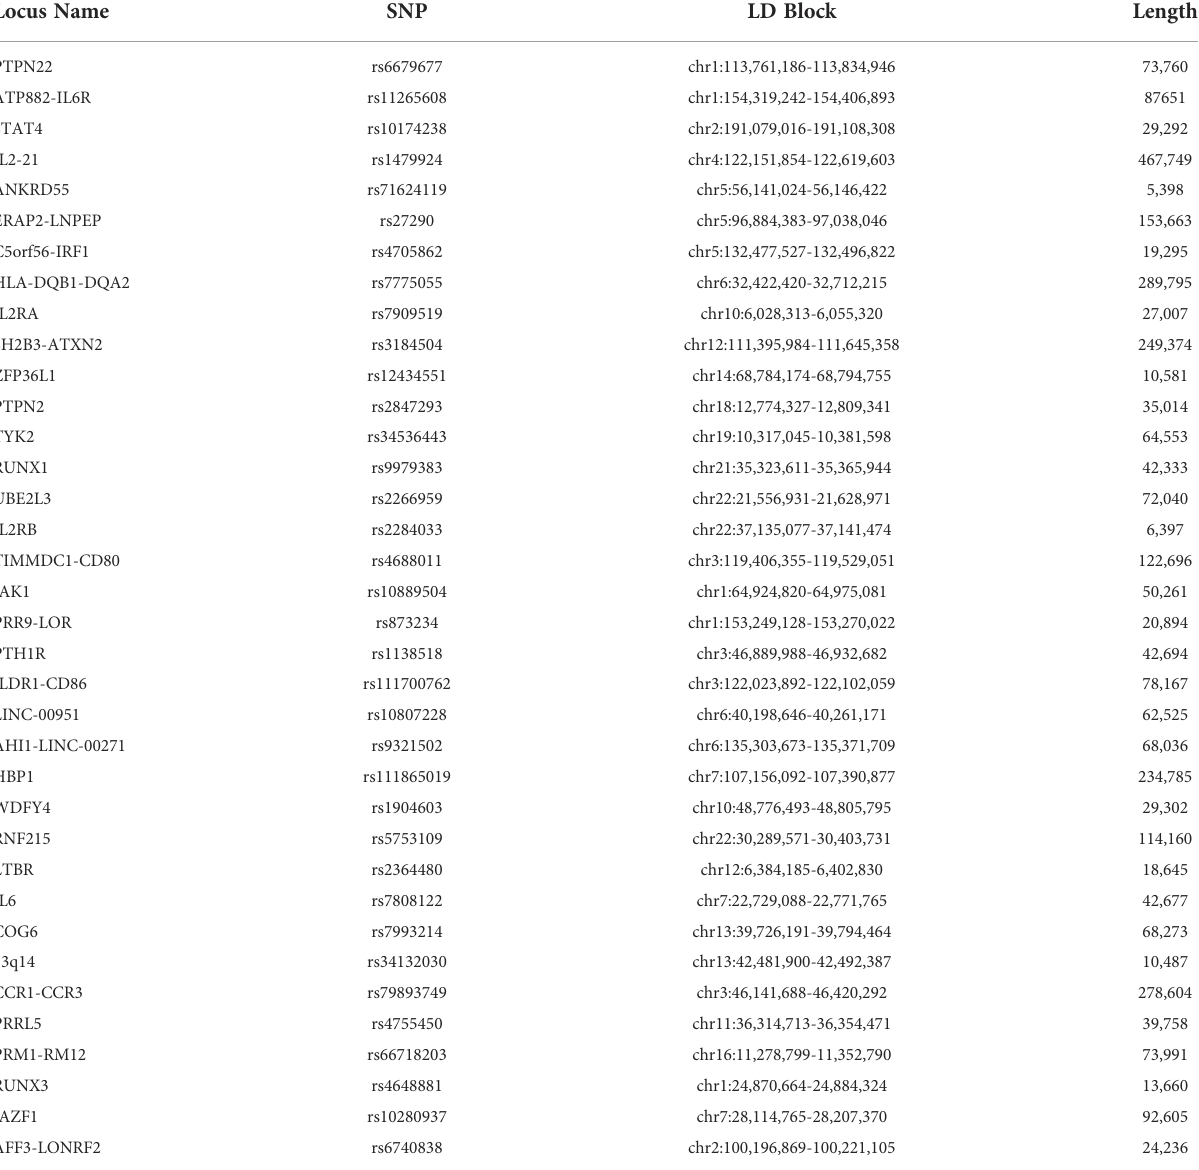
TABLE 1 Positional Information of 36 JIA risk haplotypes (r 2 = 0.80) in